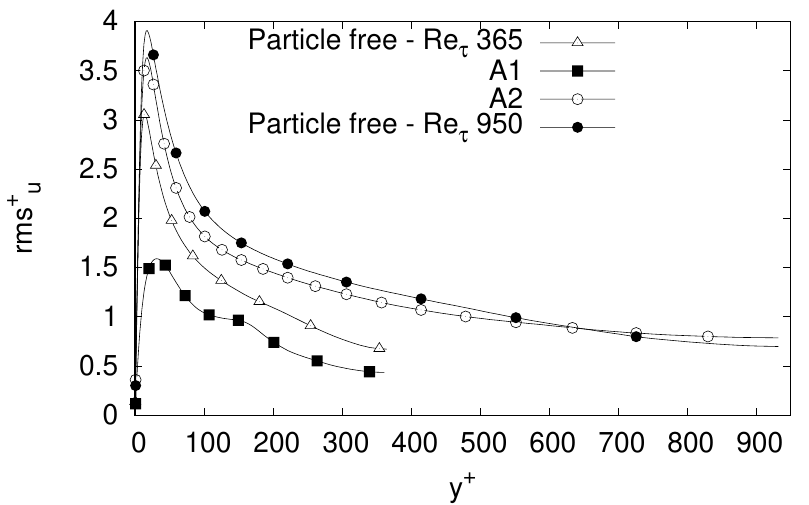
Figure 12. rms + u - Profiles for A1, A2 and particles free cases. ( A 1 : u τ = 0.073; A2: u τ = 0.188).